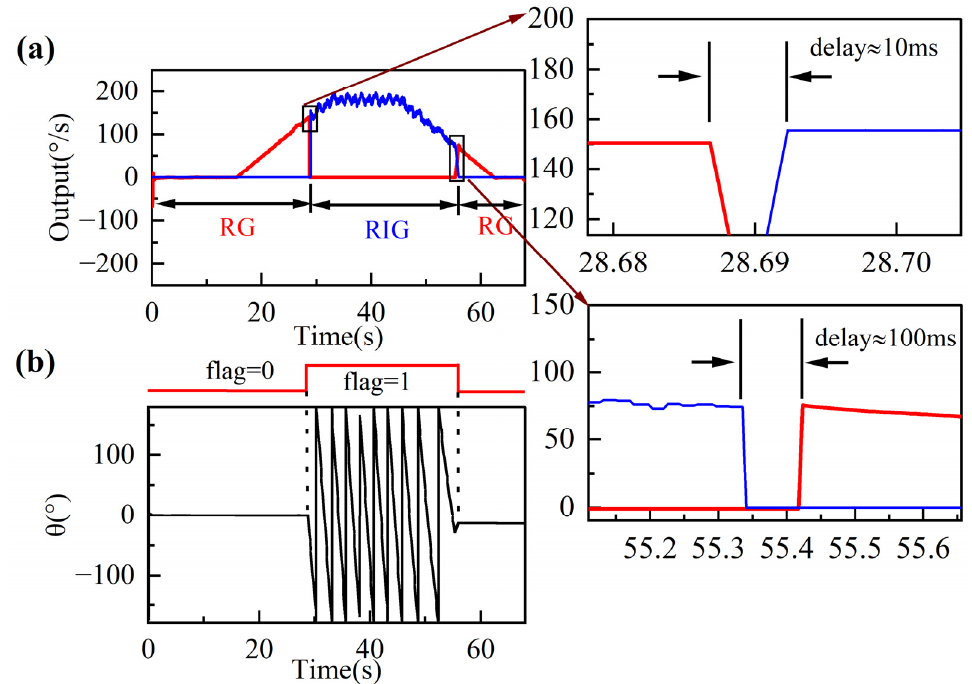
Figure 10. Process of mode switching. ( a ) Angular rate outputs of the gyro and ( b ) corresponding precession angle. The gyro starts in RG mode and switches to RIG mode after a delay of about 10 ms when the input is greater than 150°/s. It switches back to RG mode after a delay of about 100 ms when the input is less than 75°/s. The angle remains fixed in RG mode and precesses freely in RIG mode.